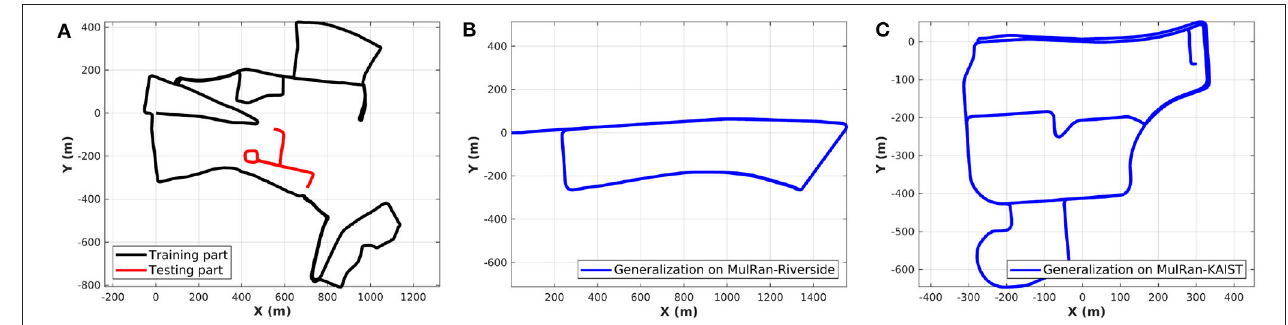
FIGURE 3 | (A) We split the trajectory of RobotCar dataset into training and testing session. (B,C) The trained model is generalized to the Riverside and KAIST of the MulRan dataset for evaluation directly, which contain a driving distance near 7 and 6 km, respectively.